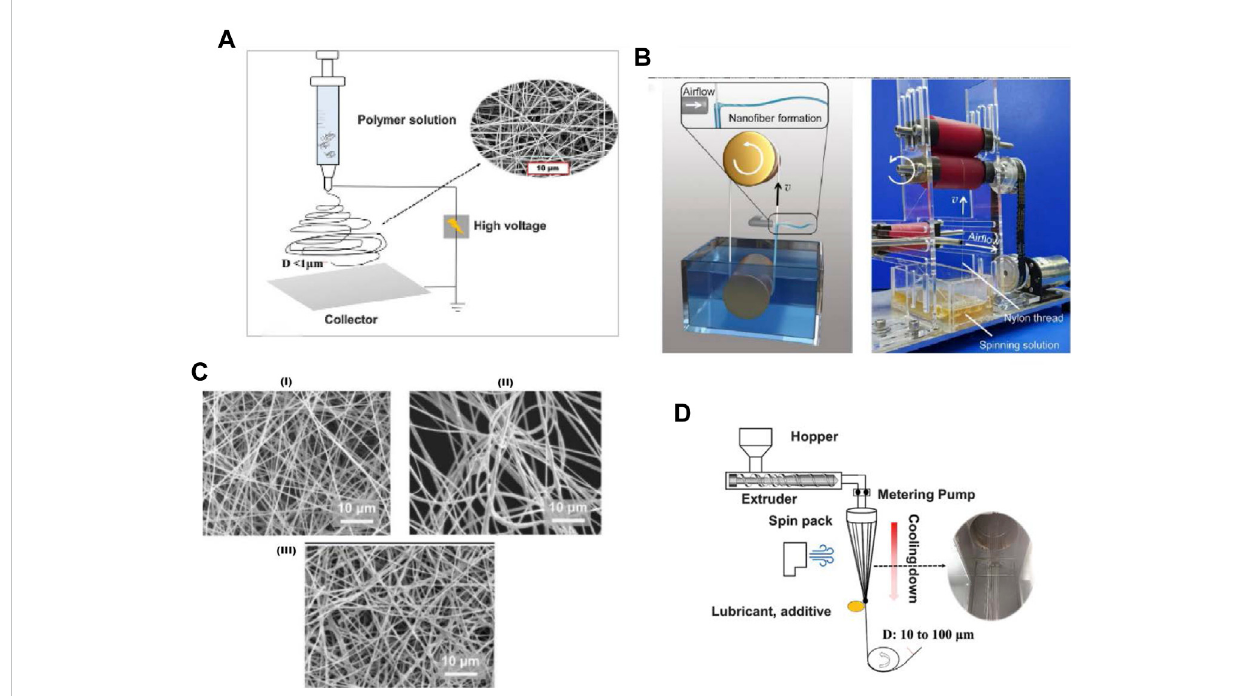
FIGURE 4 Schematic diagram of spinning equipment. (A) Schematic diagram of electrospinning device (ROSTAMITABAR et al., 2021) (B) Needle free air jet spinning with nylon rope instead of syringe (LI et al., 2022d) (C) Morphology of nano fi bers prepared by different spinning methods (CAO et al., 2021) (I) Electrospinning and air jet spinning (II) Air jet spinning (III) Electrospinning (D) Schematic diagram of melt spinning (ROSTAMITABAR et al.,